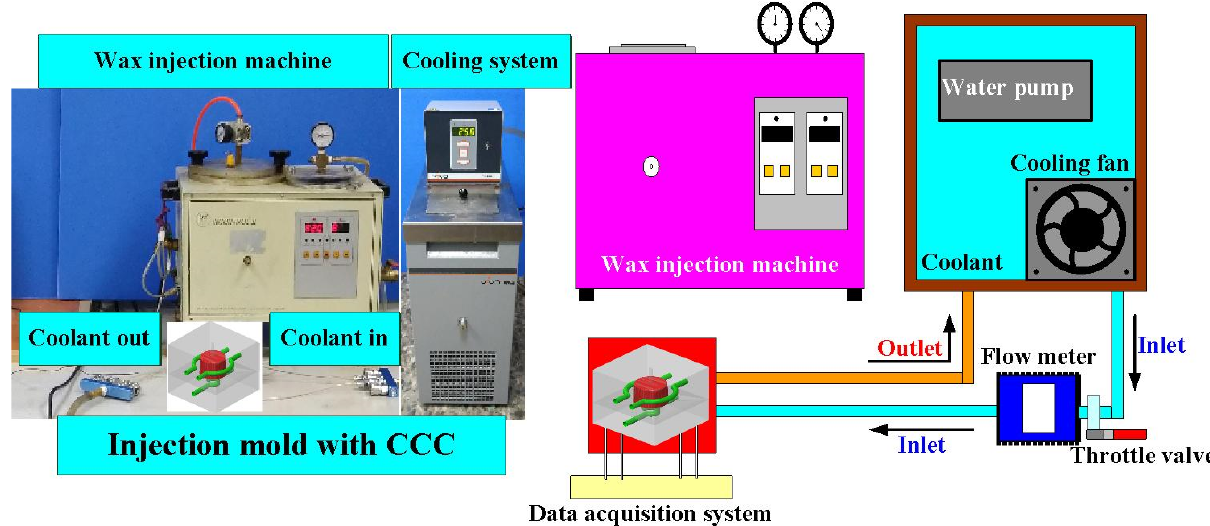
Figure 3. Experimental setup for investigating the amount of coolant leakage using a precision electronic scale.